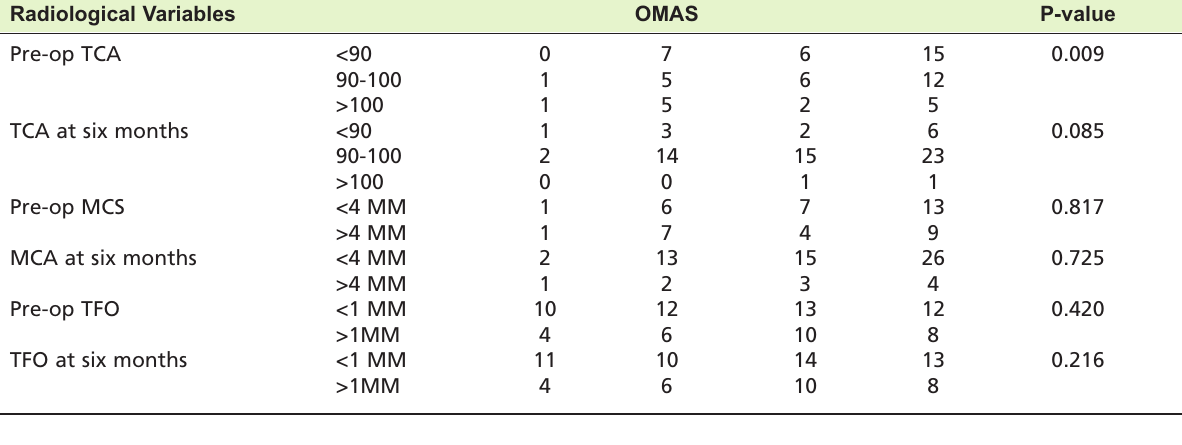
Table showing the various radiological parameters that affect the OMAS Table IV: